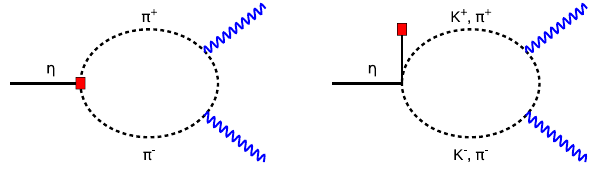
Fig. 12 Representative chiral one-loop diagrams contributing to the matrix element of the operator p 0 = i ( ¯ u γ 5 u + ¯ d γ 5 d ) needed in the soft-pionrelation(B.22).Insertionsof p 0 arerepresentedbyaredsquare